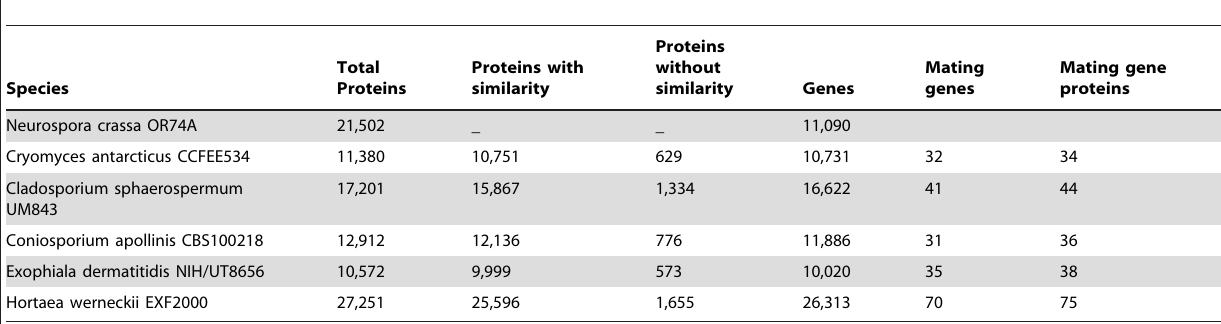
Table 3. Blast Similarity values of Cryomyces antarcticus CCFEE 534 against Neurospora crassa OR74A.